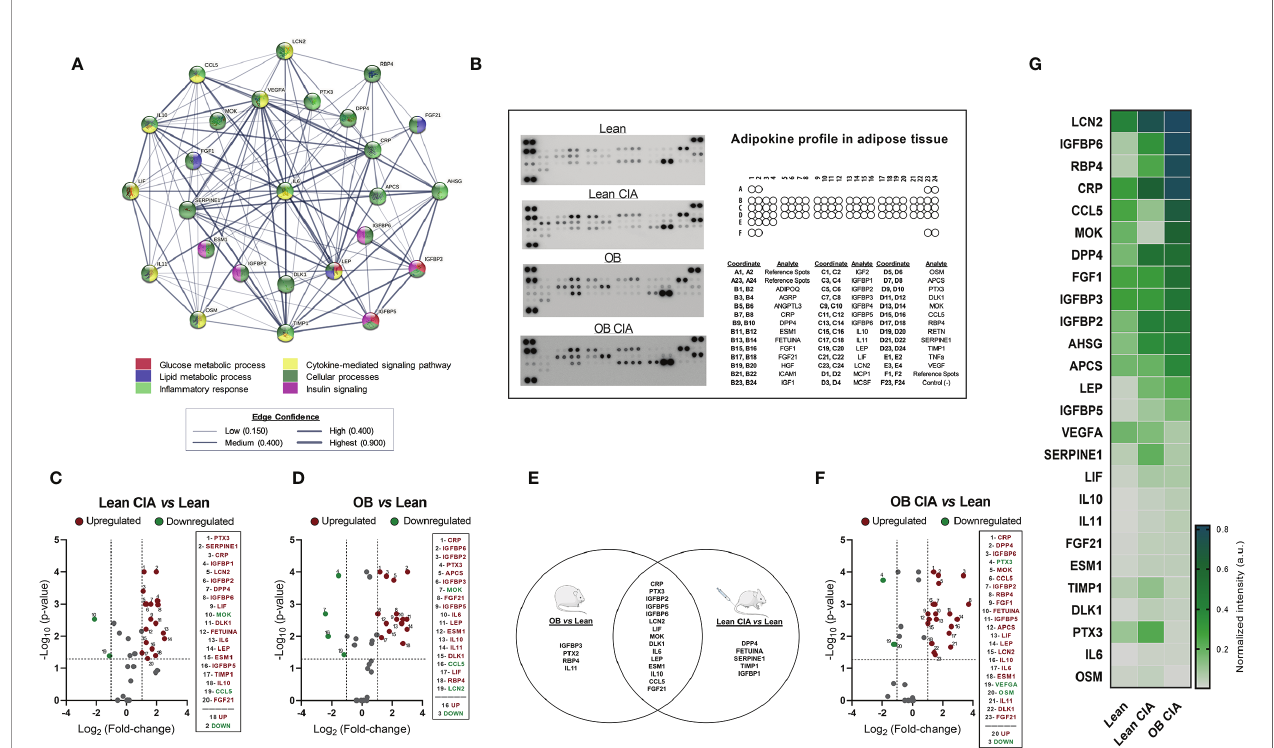
FIGURE 3 | Adipokine pro fi ling in adipose tissue of OB CIA mice. (A) Bioinformatic identi fi cation of biological functions of pro fi ling proteins in adipose tissue (STRING platform); (B) Representative images of mouse adipokine arrays and the coordinate reference of proteins; (C) Volcano plot of proteins altered in Lean CIA mice compared to Lean mice; (D) Volcano plot of proteins altered in OB mice compared to lean mice; (E) Venn diagram of common and non-common proteins altered in Lean CIA and OB mice; (F) Volcano plot of proteins altered in OB CIA mice compared to lean mice; (G) Heatmap of mean pixel density of adipokine pro fi le. Volcano plots compare the fold change and p-value of the expression of proteins between groups. Vertical dashed mark the fold change (>1) and horizontal lines mark the p-value cut-off of 0.05. Signi fi cance was determined by Student t-test (unpaired). ADIPOQ, adiponectin; AGRP, agouti-related neuropeptide; ANGPTL3, angiopoietin like 3; CRP, c-reactive protein; DPP4, dipeptidyl peptidase 4; ESM1, endothelial cell speci fi c molecule 1; FGF, fi broblast growth factor; HGF, hepatocyte growth factor; ICAM1, intercellular adhesion molecule 1; IGF, insulin like growth factor; IGFBP, insulin-like growth factor binding protein; IL, interleukin; LEP, leptin; LIF, leukemia inhibitory factor; LCN2, lipocalin-2; MCP1, monocyte chemoattractant protein-1; MCSF, macrophage colony stimulating factor-1; OSM, oncostatin M; APCS, amyloid P component serum; PTX3, pentraxin 3; DLK1, delta like non-canonical notch ligand 1; MOK, MAPK overlapping kinase; CCL5, C-C motif chemokine ligand 5; RBP4, retinol binding protein 4; RETN, resistin; SERPINE1, serpin family E receptor member 1; TIMP1, tissue inhibitor of metalloproteinases 1; TNF- a , tumor necrosis factor alpha; VEGF, vascular endothelial growth factor; CIA, collagen induced arthritis; OB, obese; MTX, methotrexate; LFN, le fl unomide; HCQ,